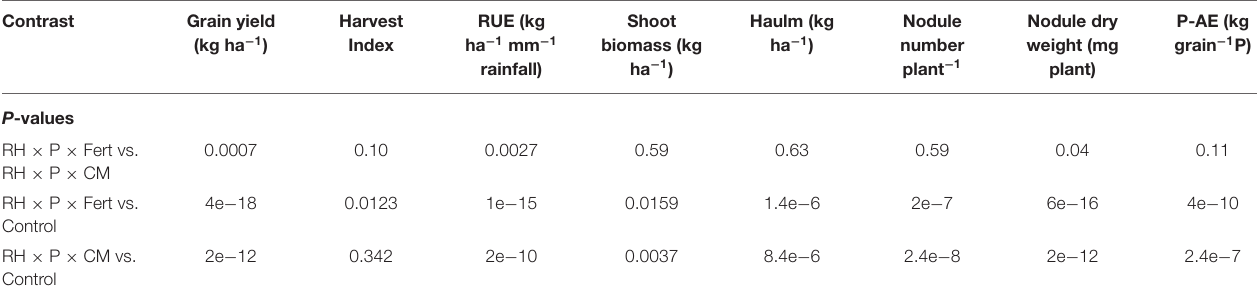
TABLE 3 | Contrast analysis of Agronomic parameters of soybean as affected by the application of rhizobia, P-fertilizer, and organic manure.